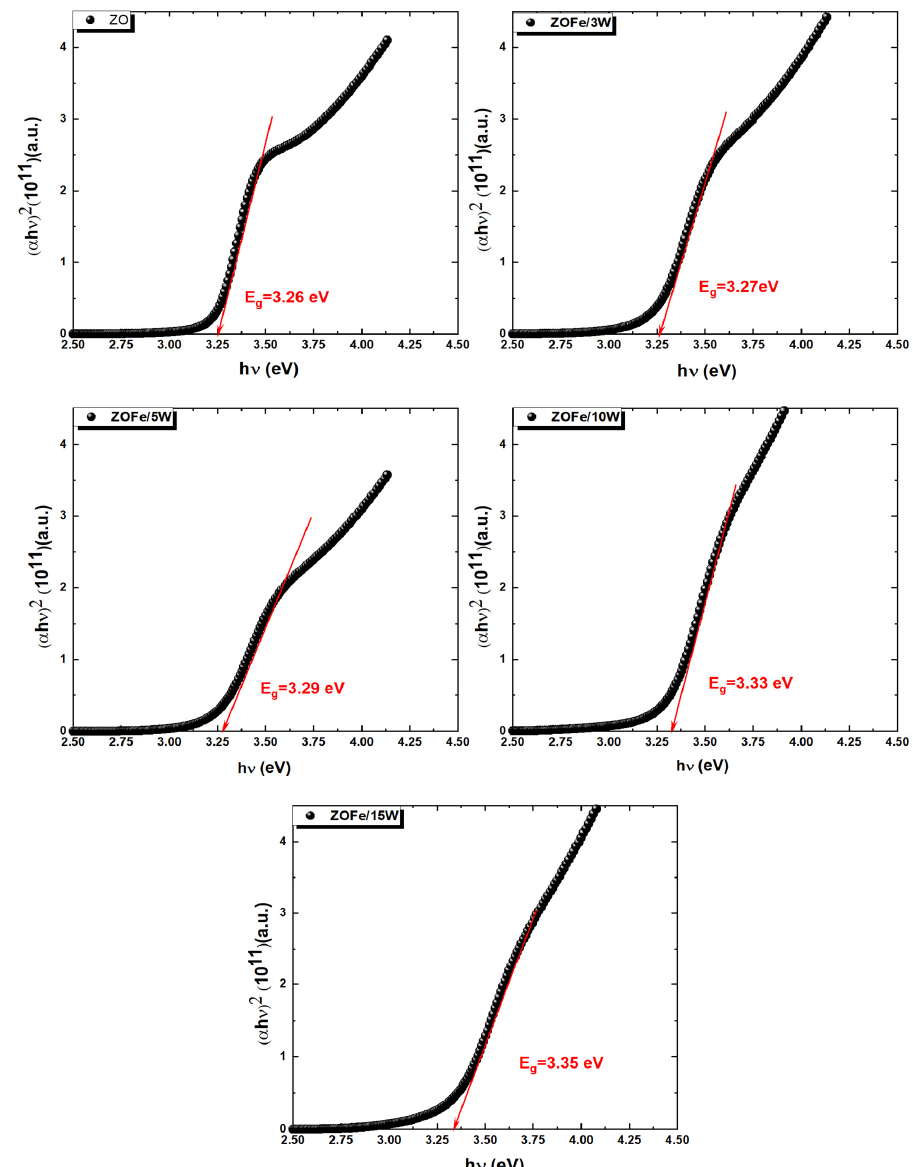
Figure 8. Plot of ( α h ν ) 2 vs. ( h ν ) for the undoped and Fe doped ZO thin films. Table 5. Energy gap values E g obtained from different methods for undoped ZO and Fe doped ZO (B) The derivative of transmittance (T) against photon energy ( h ν ) thin This method is applicable for transitions between direct band gaps [34]. The trans- mission through a film may be approximated as: 𝑇(𝐸) (cid:3406) (cid:4670)1 − 𝑅(𝐸)(cid:4671) (cid:2870) 𝑒 (cid:2961)((cid:3006))(cid:3031) where E is the energy of the incident light, R is the reflectance, and d is film thickness.